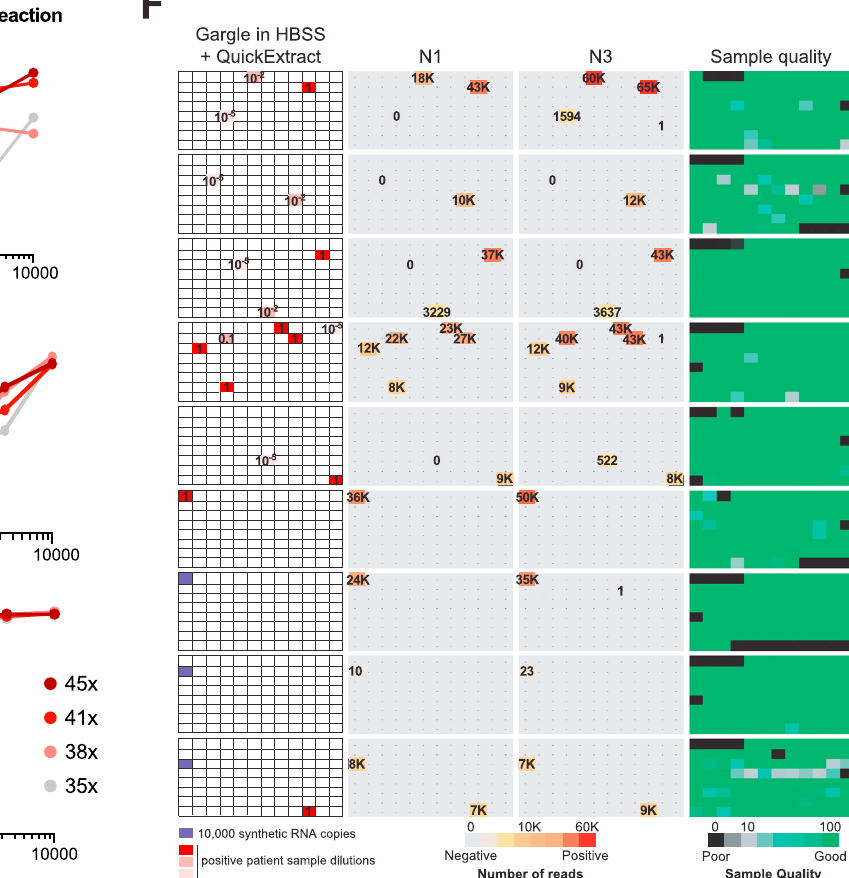
detection of SARS-CoV-2 RNA with high sensitivity and speci fi city. SARSeq robustly detects SARS-CoV-2 in patient samples from a clinical setting . To test if SARSeq robustly detects real